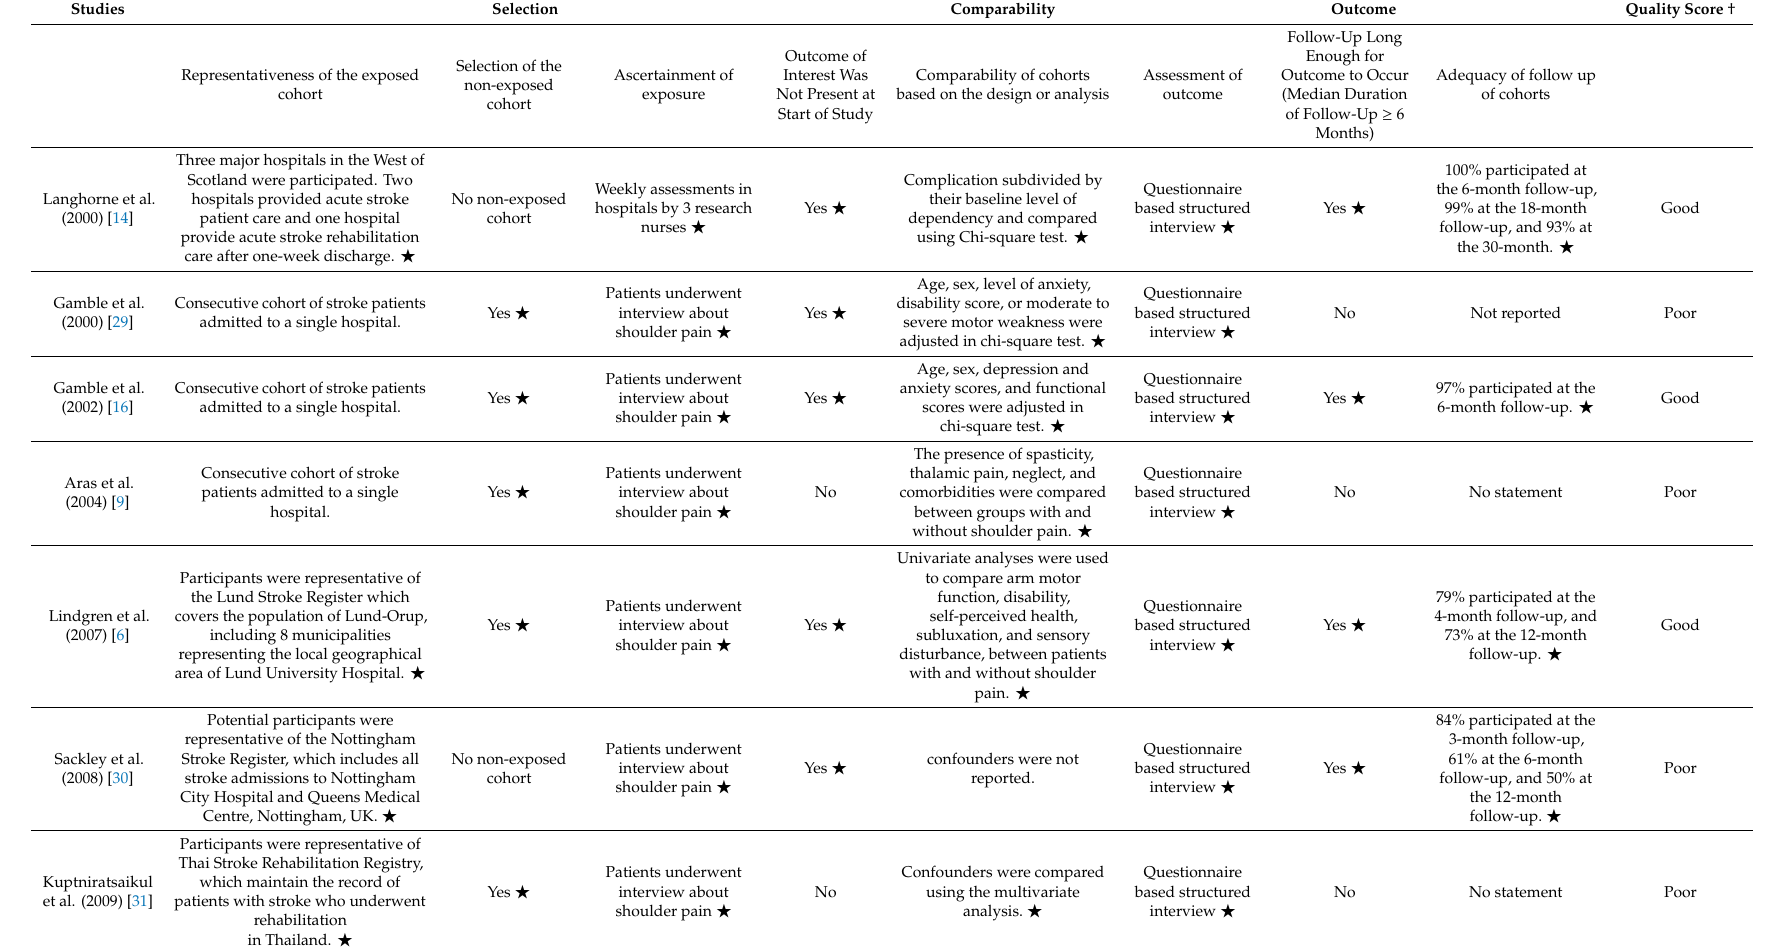
Table 2. Results of the quality assessment using the Newcastle-Ottawa Quality Assessment Scale